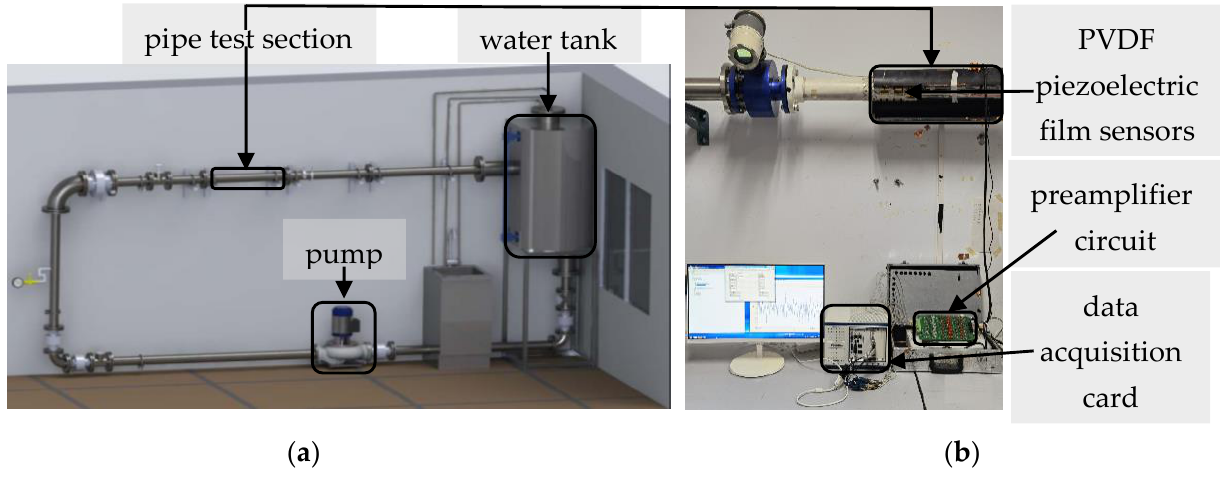
Figure 12. Experimental setup: ( a ) panoramic view; ( b ) details of the pipe and the signal processing unit.